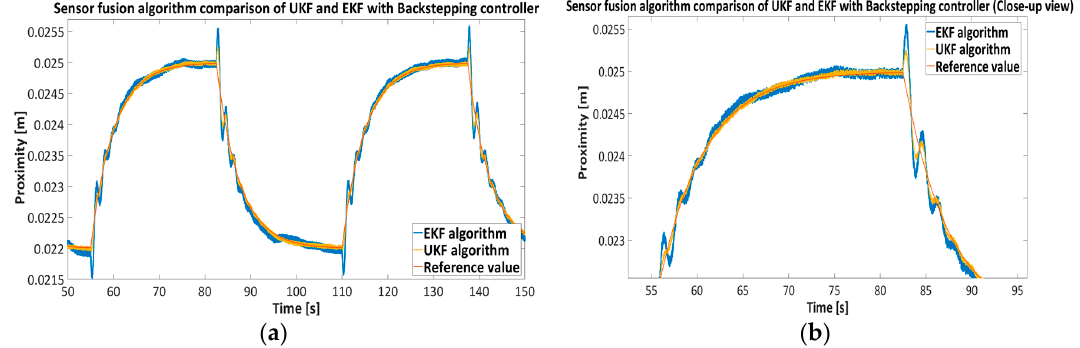
Figure 19. Comparison of the UKF and EKF sensor fusion algorithms with nonlinear backstepping feedback controller.